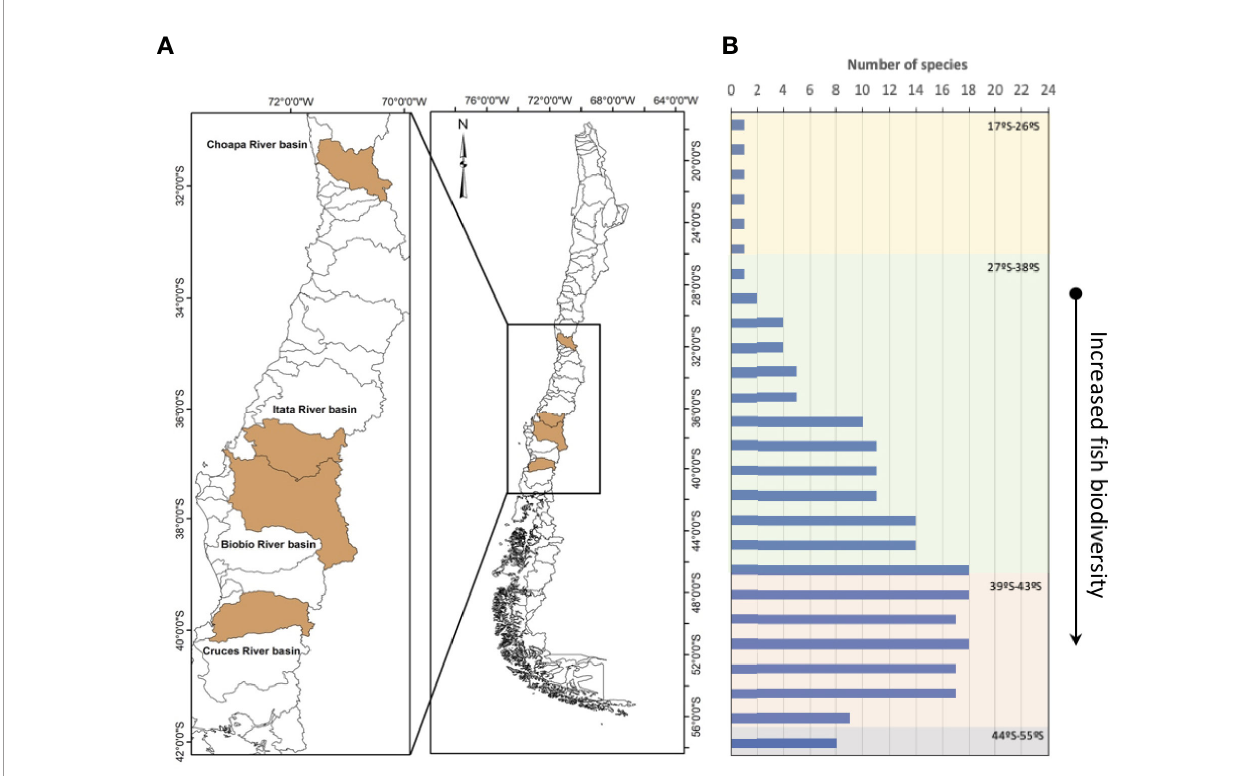
FIGURE 1 | Location of the rivers where endocrine disruption effects have been described in Chile (A) and the latitudinal fi sh biodiversity reported by the Ministry of the Environment (10) (MoE) 2018 (B)